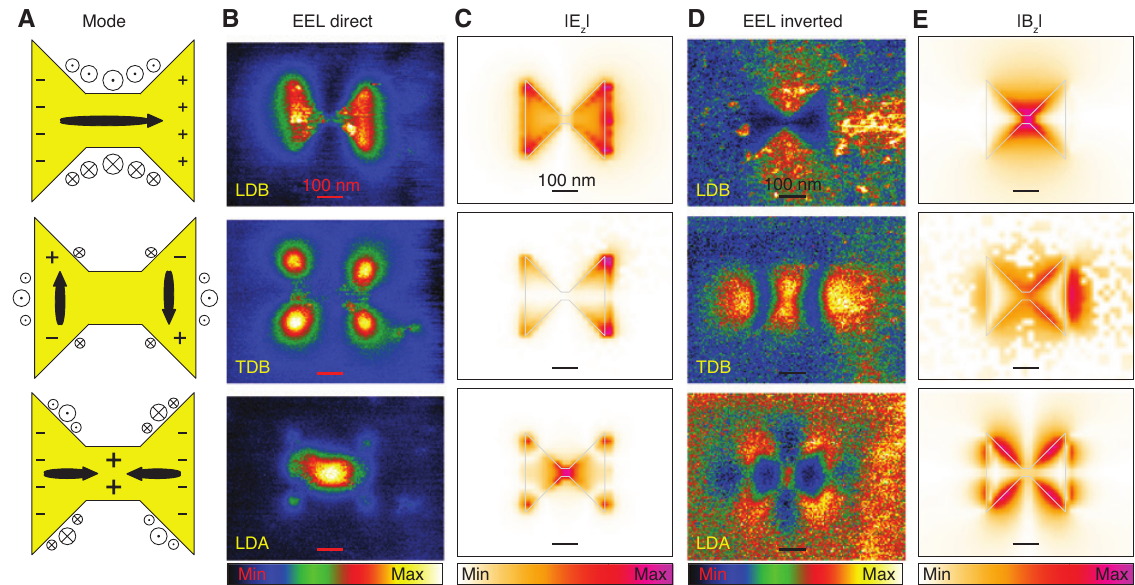
Figure 6: Experimental EEL maps and calculated fields for the LDB (1st row), TDB (2nd row), and LDA (3rd row) modes. (A) Schematic representation of the mode in the diabolo antenna. The black arrow depicts the current with the thicker middle part representing the current antinode and the thinner border parts representing the current node. Magnetic field in the plane of the antenna is schematically represented by  (outward field) and ⊗ (inward field) symbols with the size corresponding to the magnitude of the field. The node of current corresponds to the accumulation of the charge represented by + and − symbols. (B) Experimental loss intensity distribution. (C) Calculated out-of-plane electric field. (D) Experimental loss intensity distribution for Babinet-complementary antenna (inverted diabolo). (E) Calculated out-of-plane magnetic field. The length of the scale bars is 100